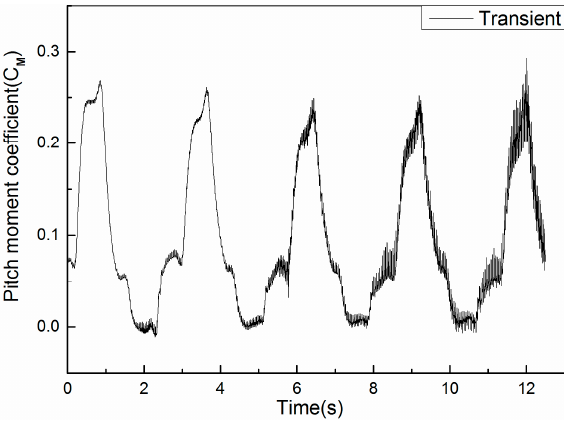
Figure 16. Time history of the wing pitching moment coefficient calculated by the transient method.